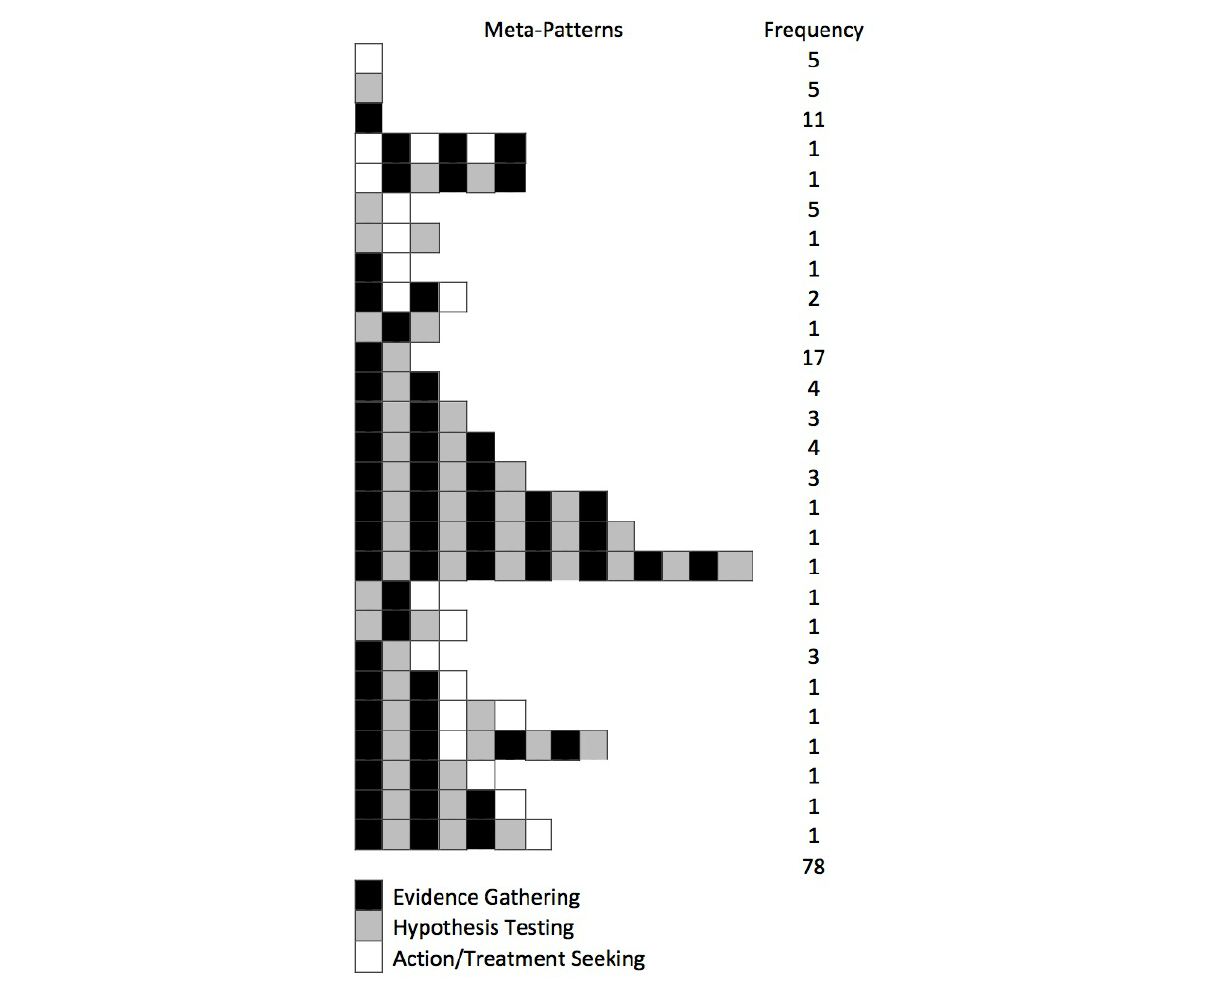
Figure 3. Frequency of each meta-pattern